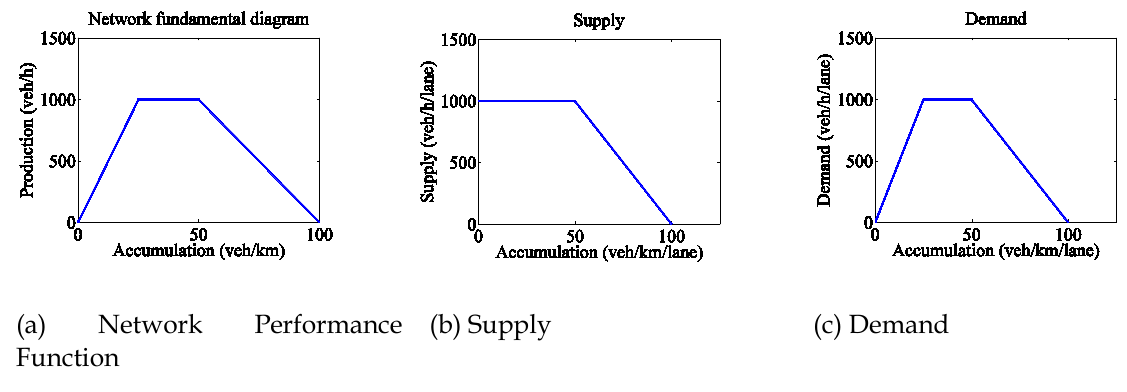
Figure 2. The factors determining the flow The dynamics of traffic are simulated in these subnetworks. The flow from cell A to cell B is determined by the minimum of three elements